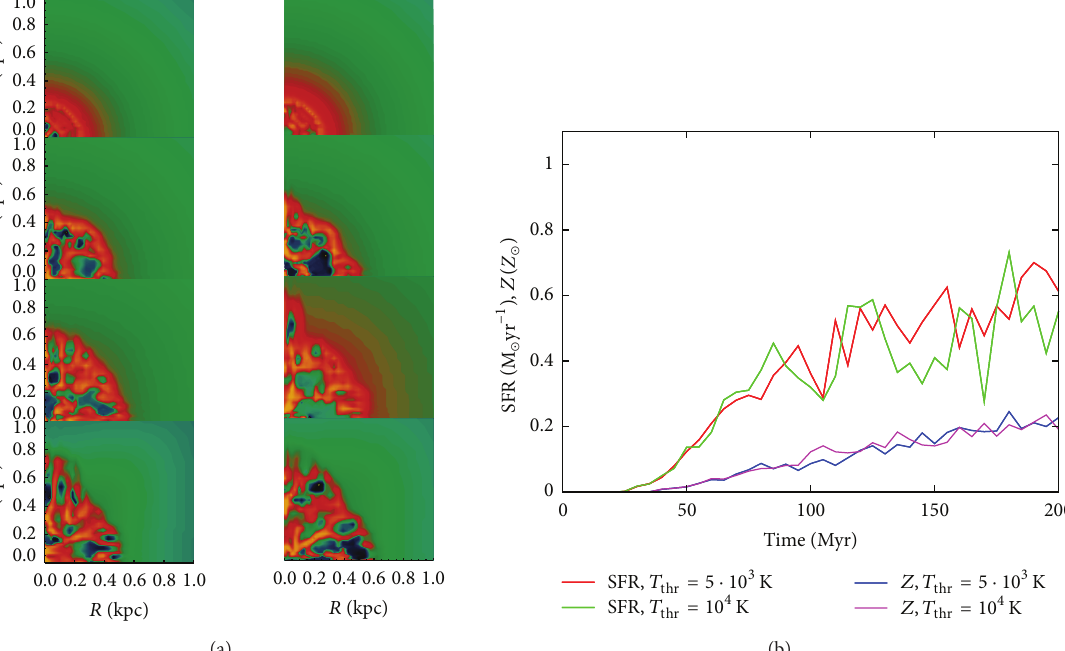
Figure 1: The effect of the temperature threshold 𝑇 above which star formation is not allowed. (a) The density distribution of gas in two thr = 5 ⋅ 10 3 K (left panels) and 𝑇 = 10 4 K (right panels). The four rows are snapshots of the evolution of the two : 𝑇 runs with different 𝑇 thr thr thr models at four different moments in time: 50 Myr (uppermost panels), 100 Myr (second row of panels), 150 Myr (third row of panels), and 200 Myr (lowermost panels). Dense gas is in orange (upper densities are 10 −23 gcm −3 ); dilute gas is in blue (lower densities are 10 −27 gcm −3 ). (b) Star formation rates (in M ⨀ yr −1 ) and global metallicities (in Z ⨀ ) for the same models shown in the left panels, during the first 200 Myr of galactic